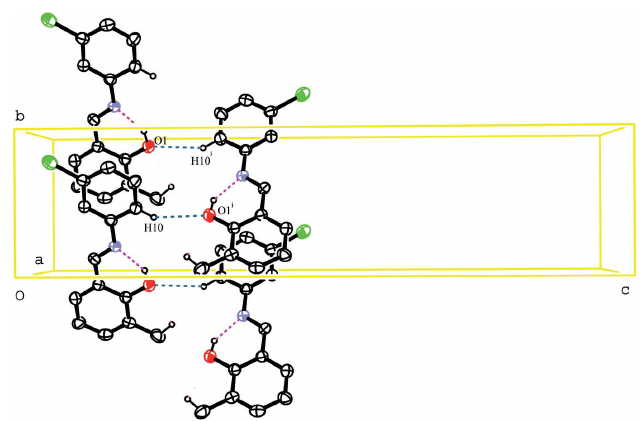
Figure 2 Diagram showing the hydrogen-bonding interactions in (I). Displacement